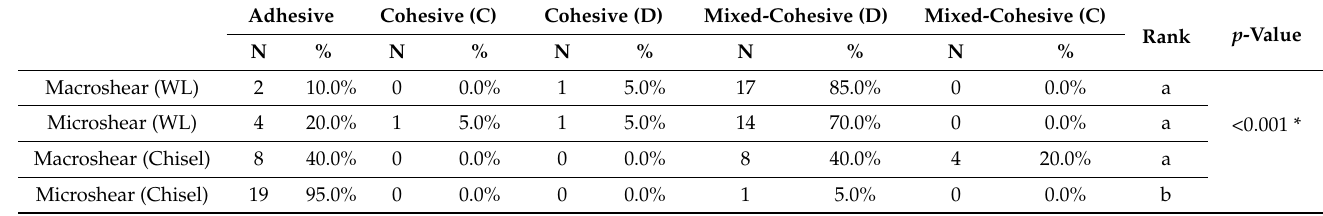
* = Significant. Different letters within the rank column indicate significant differences based on the Dunn–Bonferroni adjustment (adjusted p < 0.05).